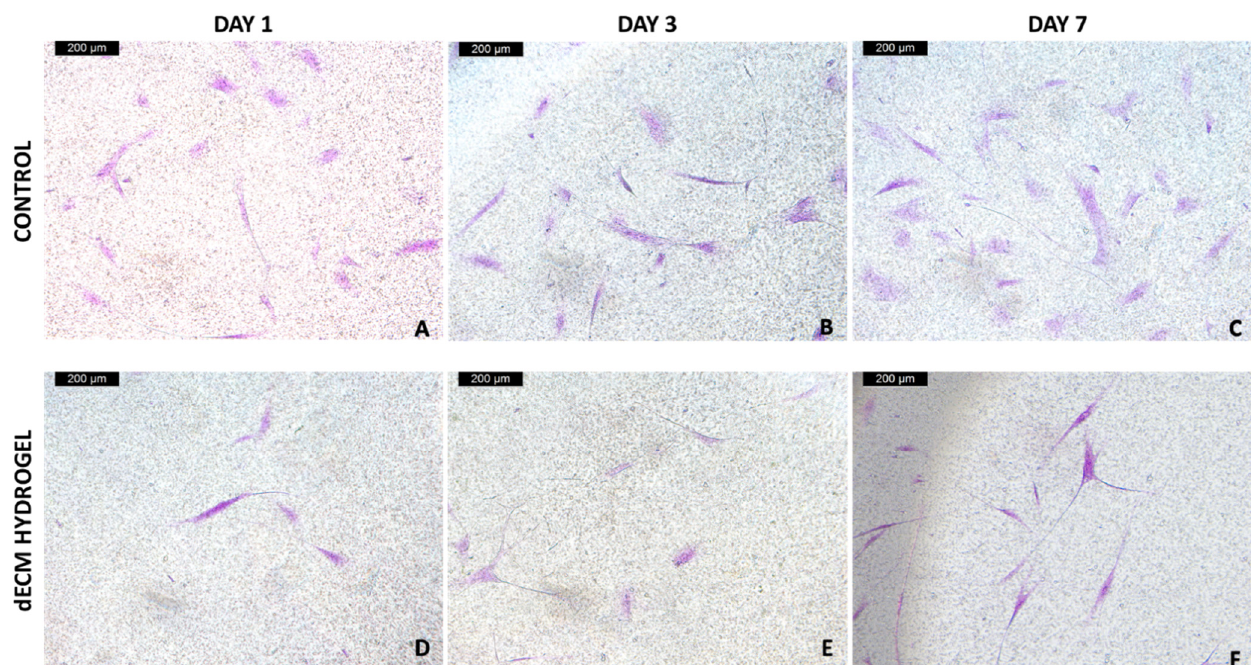
Figure 7. Crystal violet staining of the migrated NHDF. ( A , D ) migrated NHDF at the bottom of control and dECM hydrogel transwells at day 1. ( B , E ) migrated NHDF at the bottom of control and dECM hydrogel transwells at day 3. ( C , F ) migrated NHDF at the bottom of control and dECM hydrogel transwells at day 7. Magnification 10×. Scale bar 200 μ m.